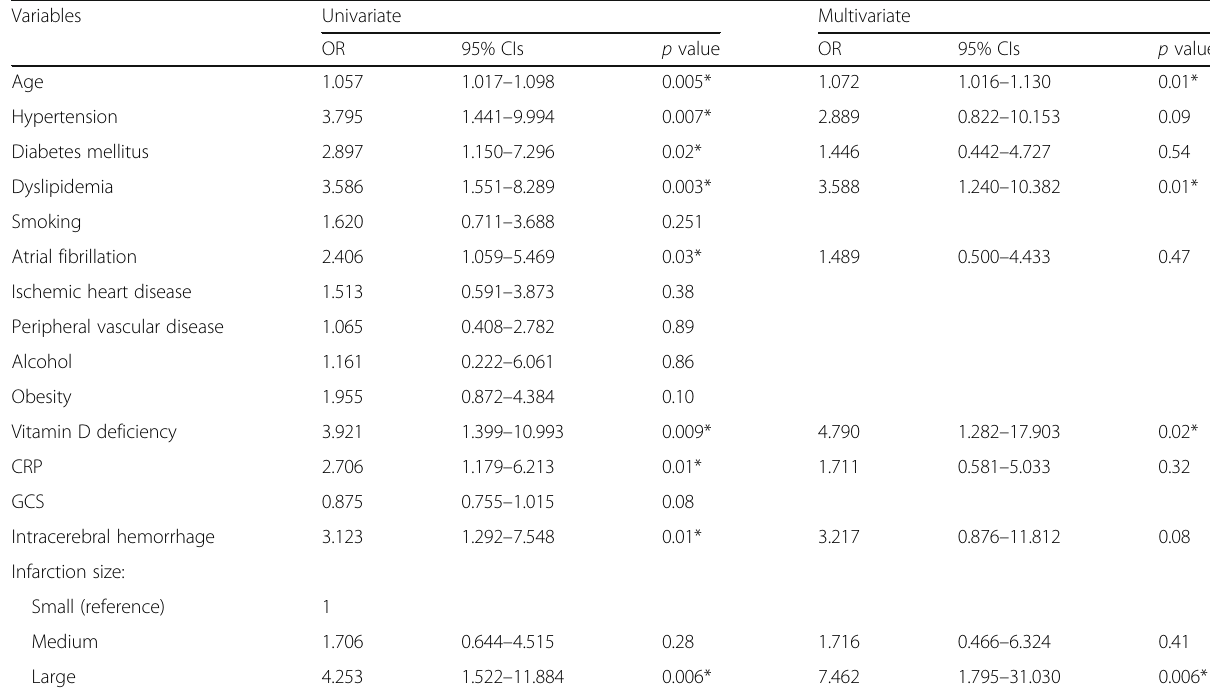
Table 2 Univariable and Multivariable Logistic Regression analysis of factors with stroke severity (NIHSS)